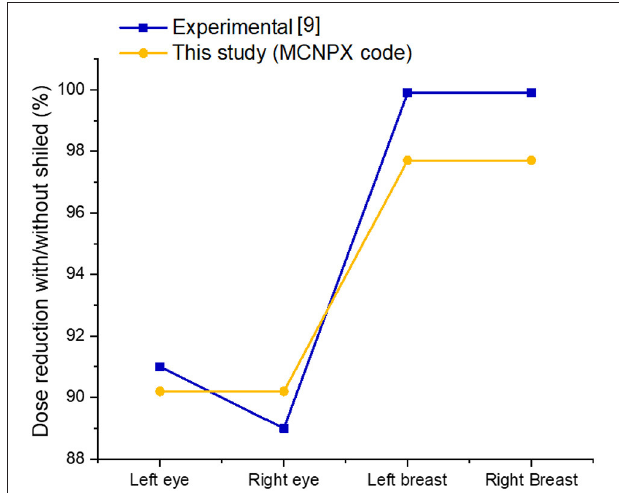
FIGURE 5 | Comparison of dose reductions achieved in experimental and Monte Carlo studies.